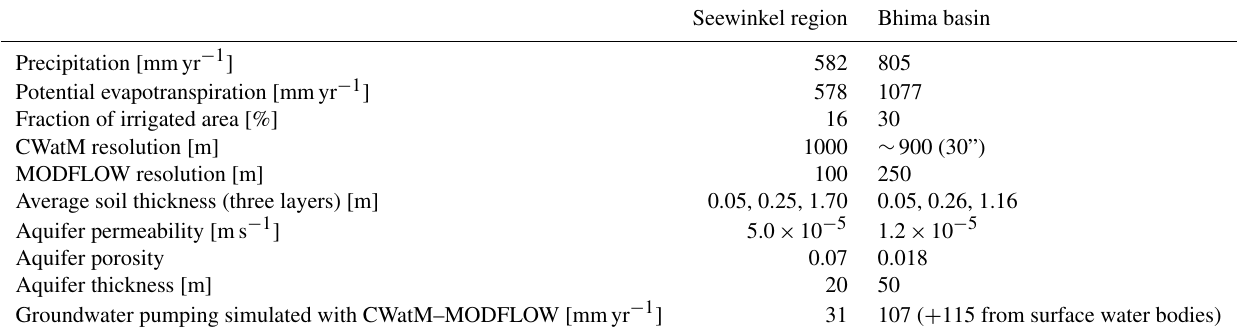
Figure 3. Location of the two study regions. (a) The Seewinkel region in Austria. Blue lines represent canals included in the model. CWatM and MODFLOW are respectively set up at 1km and 100m resolutions. (b) The upper Bhima basin in India. Blue lines represent the main rivers. CWatM and MODFLOW are set up at ∼ 0.9km and 250m resolutions, respectively. Table 1. Main characteristics and model properties of Seewinkel and Bhima. Annual averages are given for 1983–2016 and 2000–2009 periods for Seewinkel and Bhima, respectively. Aquifer permeability and porosity are obtained after calibration. Seewinkel region Bhima